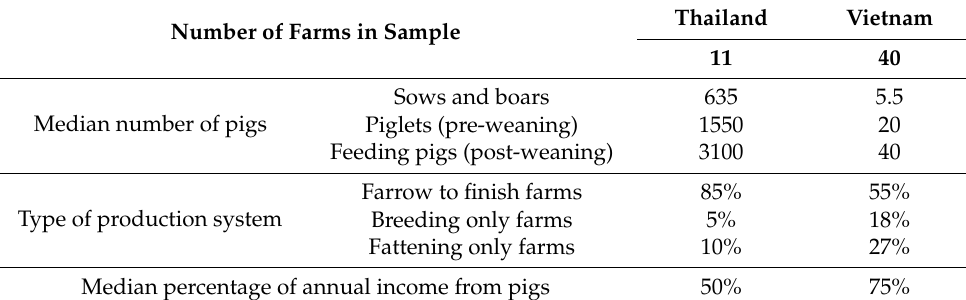
Table 3. Demographic information of the sample of pig farms for the case studies in Thailand and